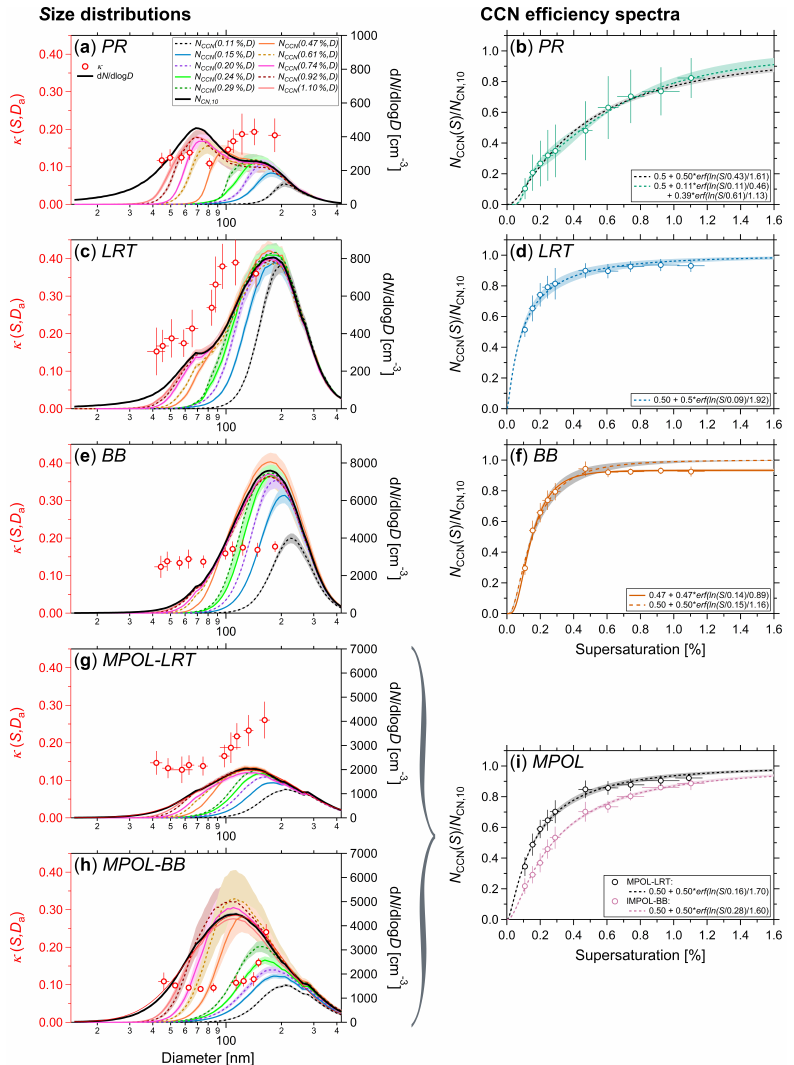
Figure 6. Overview of case study conditions for empirically pristine rain forest (PR), long-range transport of African aerosols (LRT), biomass burning (BB), and mixed pollution of African and Amazonian sources (MPOL), showing size dependence of hygroscopicity param- eter ( κ(S,D a )), number size distributions of total aerosol particles ( N CN (D )), and number size distributions of cloud condensation nuclei ( N CCN (S , D )) at all 10 S levels ( S = 0.11–1.10%) (left side) as well as CCN efficiency spectra with erf fits (right side). For the size distribu- tions (left), values of κ(S,D a ) for every S level are plotted against their corresponding midpoint activation diameter, D a (S ). For κ(S,D a ), the error bars represent 1SD. For D a (S ), the experimentally derived error is shown. The standard errors of the number size distributions – N CN (D ) and N CCN (S , D ) – are indicated as shading of the individual lines. For the CCN efficiency spectra (right), N CN , 10 was chosen as a reference concentration. The experimental data were fitted with single- or double-erf fits dashed lines with shading as uncertainty of the fits. The error bars at the markers represent the measurement error in S and 1SD in the N CCN (S)/N CN , 10 dimension. The shading represents the uncertainty of the fits. An overview of the erf fits from all case study conditions and seasonal averages can be found in Fig. 11. The parame- ters of all erf fits are summarized in Table 4. Data for PR conditions in (a) and (b) represent averages of all PR BC ∩ CO episodes during the entire CCN measurement period as defined in Sect. 2.7. For the PR CCN efficiency spectrum, the double-erf fit is the better representation, although the single-erf fit also works as a good approximation. Data for LRT conditions, shown in (c) and (d) , represent the LRT3 period as shown in Fig. 3. A single-erf fit describes the experimental data accurately. Data for BB conditions, shown in (c) and (d) , represent the time period in August 2014 as shown in Fig. 4. For the BB case, the experimental data have been fitted with a single-erf fit with two modifications: (i) the “default” fit with predefined variable a 1 = 1 as utilized for all other case studies tends to overestimate N CCN (S)/N CN , 10 at high S ; (ii) a corresponding fit with a free variable a 1 describes the experimental data more accurately. Data for MPOL conditions were separated into a MPOL-LRT case (g) , representing sulfate-rich African aerosols, and a MPOL-BB case (h) , representing plumes from close-by fires. MPOL CCN efficiency spectra are combined in (i) including single-erf fits. All fit parameters of the erf fits shown here are summarized in Table 4. The colors of the CCN efficiency spectra were chosen according to Wong